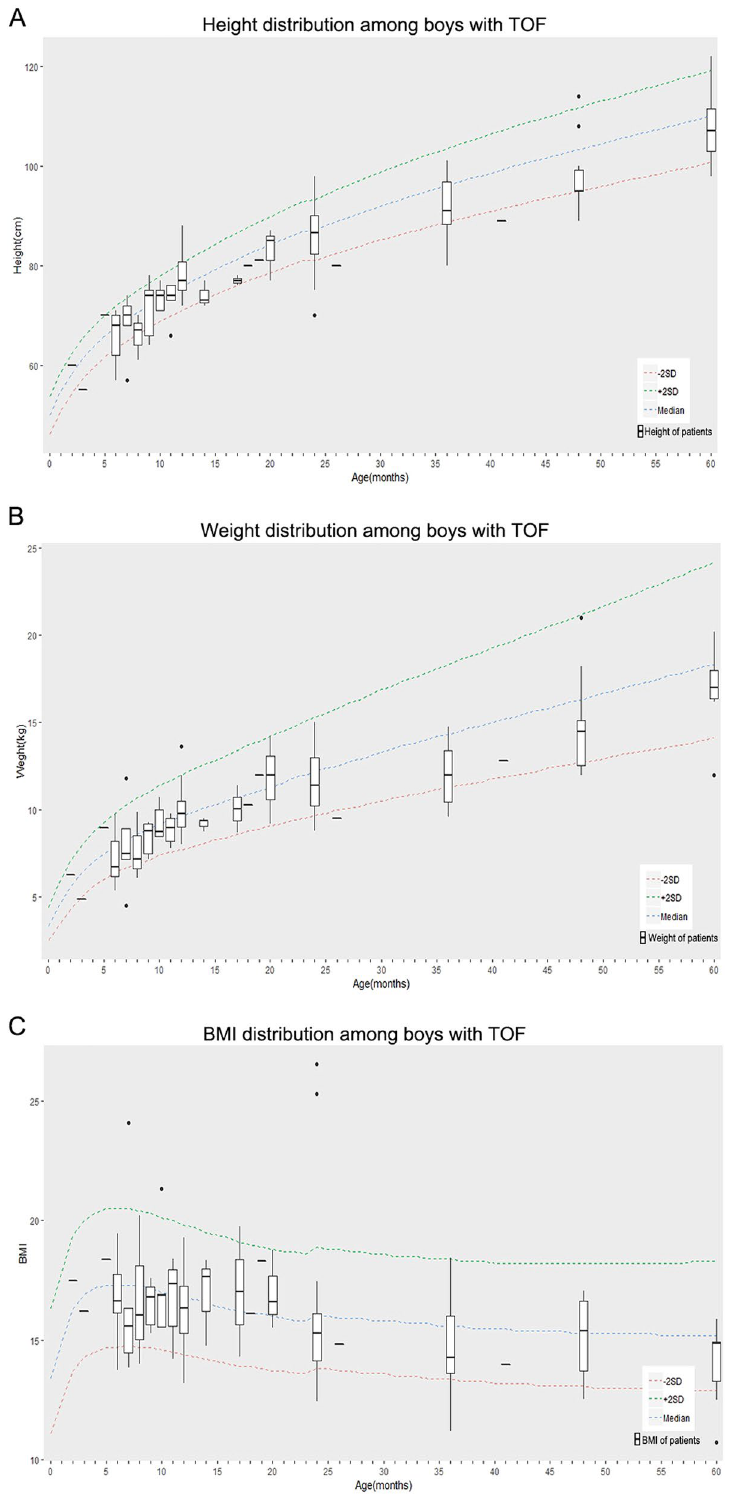
Figure 1. Growth charts for boys with TOF (total number = 138). ( A ) Height for age in TOF patient boys compared with normal chart. ( B ) Weight for age in TOF patient boys compared with normal chart. ( C ) BMI for age in TOF patient boys compared with normal chart. The dotted line represents the world standard value for the height, the green dotted line represents + 2SD, the blue dotted line represents Median, and the red represents -2SD. The data are calculated based on gender and age and calculated in the R Programming